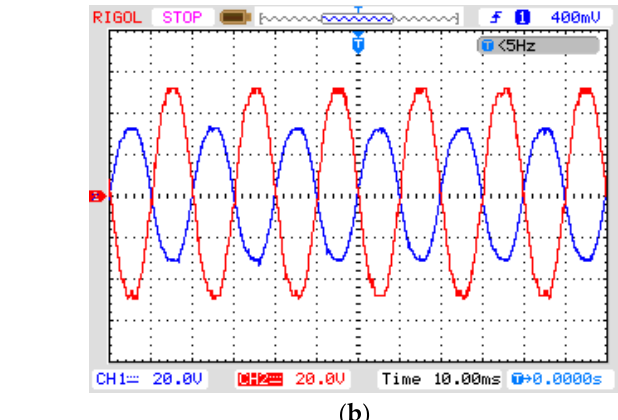
Figure 16. Practically obtained results of output voltage (red) with respect to input (blue) for output step-up process in ( a )